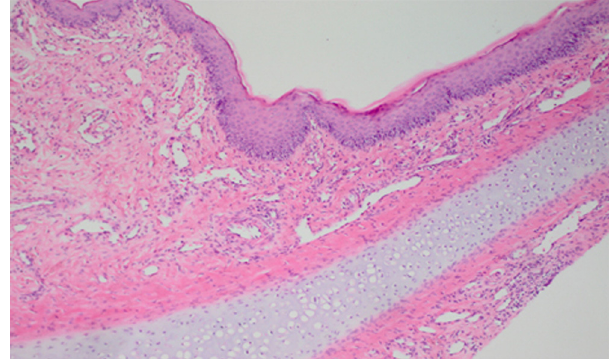
Normal histological appearance (hematoxylin---eosin [H---E] 100 × ).